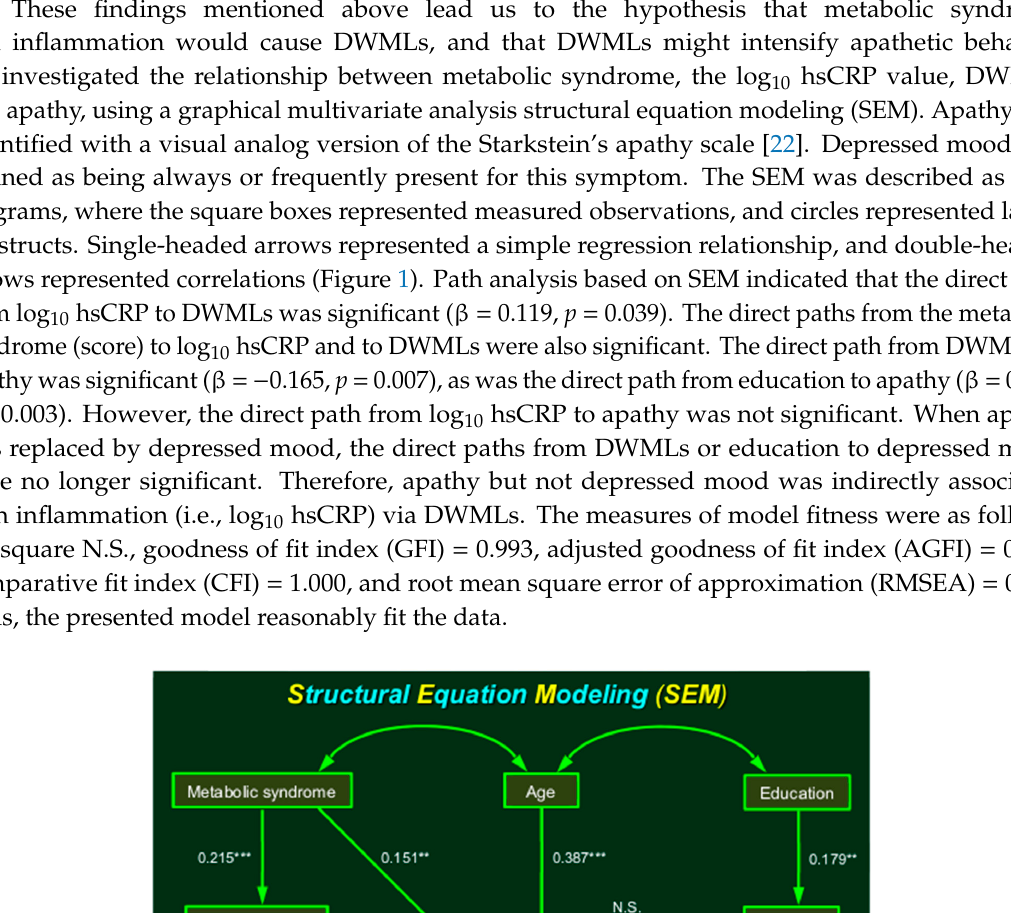
Table 2. Potential Risk Factors for Deep White Matter Lesions (DWMLs).